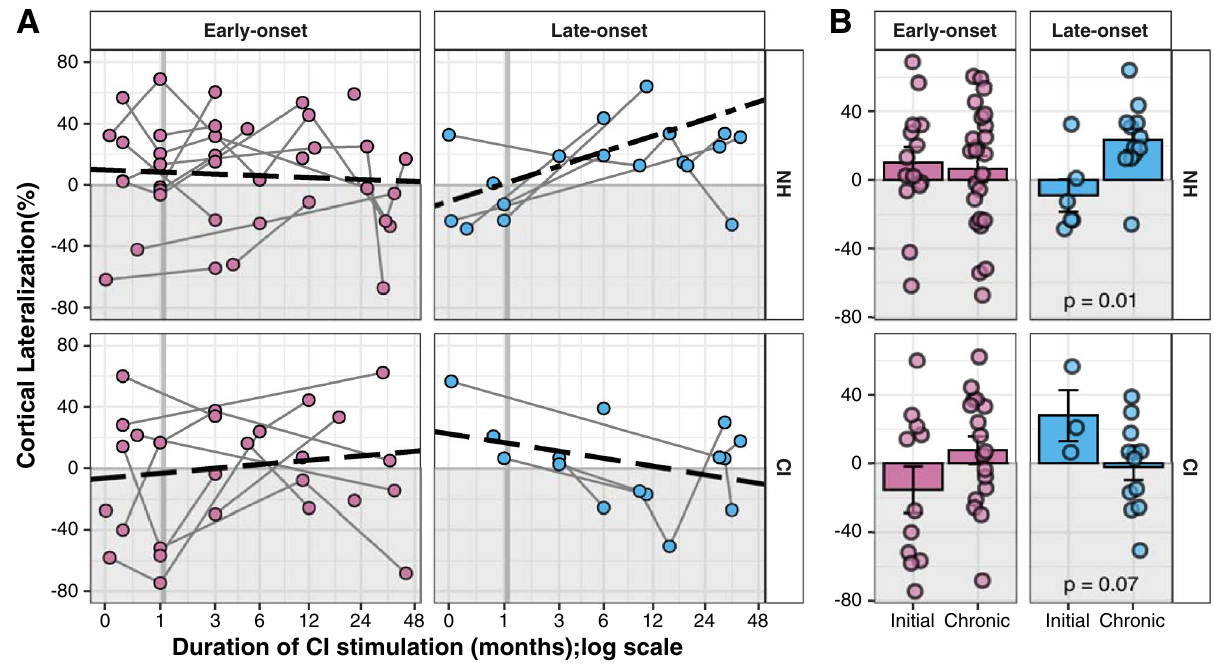
Figure 4. Changes in cortical lateralization with CI use. (A) Cortical lateralization to stimulation of each ear is plotted for individual children with duration of CI use (early-onset NH ear: 38 responses in 15 children; late- onset NH: 18 responses in 6 children; early-onset CI ear: 28 responses in 15 children; late-onset CI: 15 responses in 6 children). Values for both ears show variability which is maintained over time in the early-onset group. The late-onset group shows abnormally strong responses in ipsilateral cortex (-values) to NH stimulation initially which reverse with CI use ( F (1, 6.71) = 4.49, p = 0.07). However, expected contralateral lateralization to CI stimulation (+ values) measured at initial CI use is lost with chronic CI experience ( F (1, 13.68) = 2.28, p = 0.15). (B) Mean (± 1 SE) cortical lateralization data quantify the overall change between initial and chronic periods of CI use, indicating no significant changes in the early-onset group (p > 0.05) but significant shifts in the late-onset group that depends on the ear stimulated (interaction ear x period: F (1,33) = 11.88, p < Expected cortical representation increases with amount of consistent daily CI use. Consist- ency of device use during the chronic stage of CI use (≥ 3 month) was analyzed using the average hours of CI use per day. These data were extracted from a datalog kept by the CI speech processor. As shown in Fig. 5A, the average hours of device use per day varied from 1 to 11 h and was significantly longer in early-onset group (mean ± s.d., range, median: 6.99 ± 2.04 h, 3.00–10.99 h, 7.06 h) than late-onset group (mean ± s.d., range, median: 3.22 ± 2.11 h, 1.07–7.57 h, 2.32 h) but did not change over time (Fig. 5A, group: F (1,32.30) = 6.76, p = 0.01; time: F (1,22.08) = 0.05, p = 0.82, group × time: F (1,22.08) = 1.36, p = 0.26). The distribution of daily CI use, plotted in Fig. 5B, further reveals the differences in the distribution of daily CI use between the two groups (two-sample Kolmogorov–Smirnov test, D = 0.69, p < 0.01). The effect of consistent daily CI use on the change in cortical lateralization over the period of chronic CI use per child was assessed. Cortical lateralization over the log of time, as shown in Fig. 4A, was extracted from the associated mixed model for each child. Negative values indicated changes away from expected contralateral lateralization and positive values indicated changes toward the expected contralateral lateralization with CI use. These values are plotted by the amount of daily CI use in Fig. 5C. Cortical lateralization measures were significantly affected by daily CI use and group; both of these factors interacted with ear stimulated (daily CI